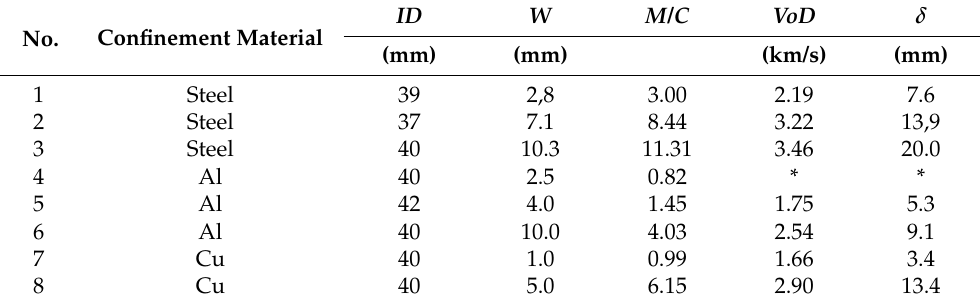
Table 1. Measurement results.